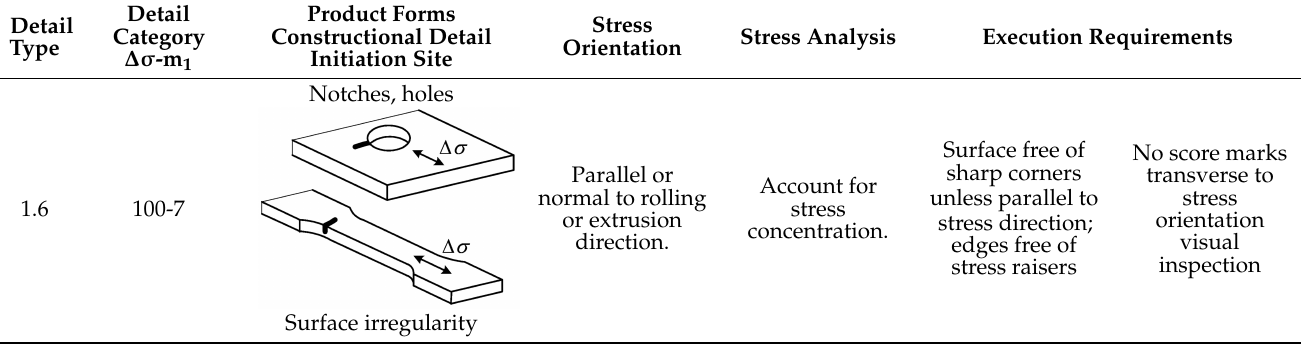
Table 7. Detail type 1.6, as per EN 1999-1-3, Table